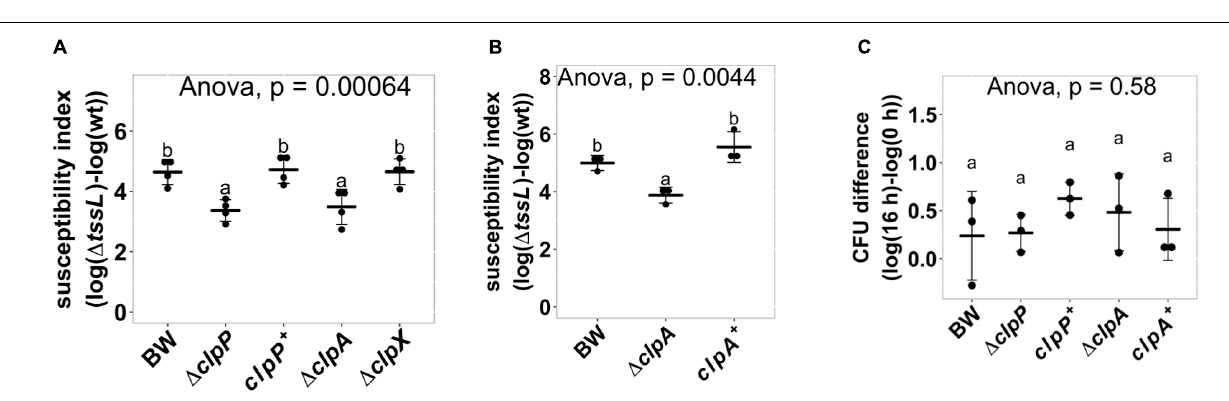
FIGURE 6 | ClpP associated AAA + ATPase ClpA but not ClpX is involved in enhancing Agrobacterium tumefaciens type VI secretion system (T6SS) antibacterial activity. (A) A. tumefaciens T6SS antibacterial activity against Escherichia coli (cid:49) clpP and its complement strain, (cid:49) clpA and (cid:49) clpX . The A. tumefaciens and the E. coli were co-cultured at a ratio of 10:1 on Agrobacterium Kill (AK) agar medium for 16 h. Afterward, the recovery of E. coli strains was quantified, and the susceptibility index was calculated by subtracting the difference of the recovered log(cfu) of that attacked by (cid:49) tssL to that by wild-type A. tumefaciens C58. (B) A. tumefaciens T6SS antibacterial activity assay and the susceptibility index were performed as described in (A) using E. coli wild type (BW), (cid:49) clpA , and (cid:49) clpA complemented with clpA expressed on plasmid ( clpA + ). (C) Growth of E. coli when co-culturing with the (cid:49) tssL A. tumefaciens . Data in (A – C) are mean ± SD of at least three independent experiments. Statistical analysis involved single-factor analysis of variance (ANOVA) and Tukey honestly significant difference (HSD) with P < 0.05 for statistical significance. Two groups with significant differences are indicated with different letters (a and